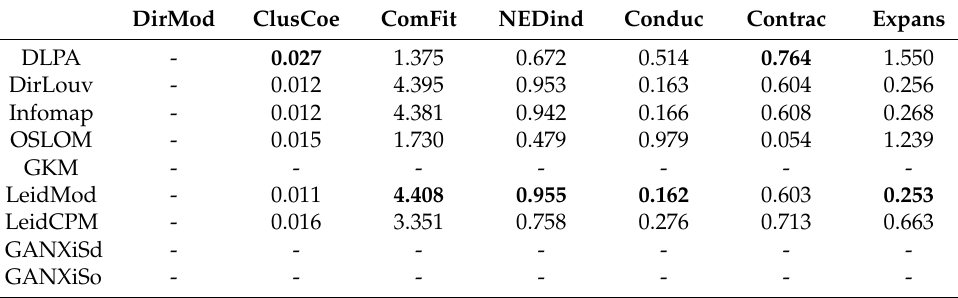
Table 7. Results of evaluations by metrics on the Charlie Hebdo